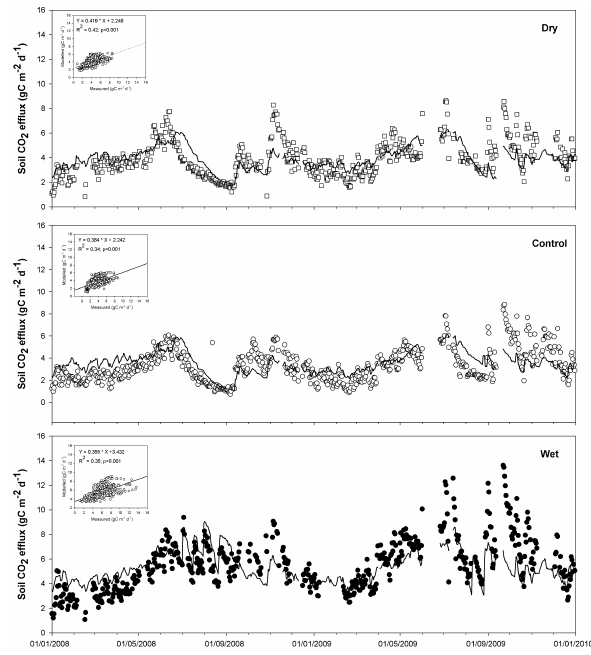
Fig. 4. Continuously measured (open symbols) and modelled (line) daily soil respiration for 2008 and 2009, in the (a) dry, (b) control and (c) wet plots. Correlation between modelled and measured data are reported for each treatment in a top left panel.